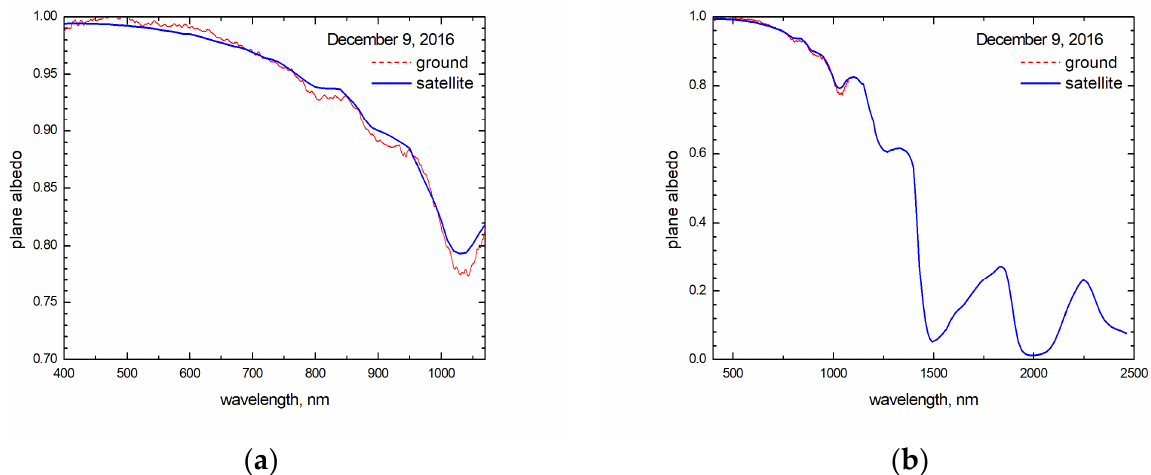
Figure 3. ( a , b ) The snow spectral plane albedo derived from dual—channel (443 and 865 nm) satellite (blue line) and ground (red) measurements. The measurements were performed on 9 December 2016 at Dome C in Antarctica. The satellite-derived snow albedo is provided on the spectral grid 10 nm. The right panel gives the plane albedo in a broader spectral range not covered by ground measurements.